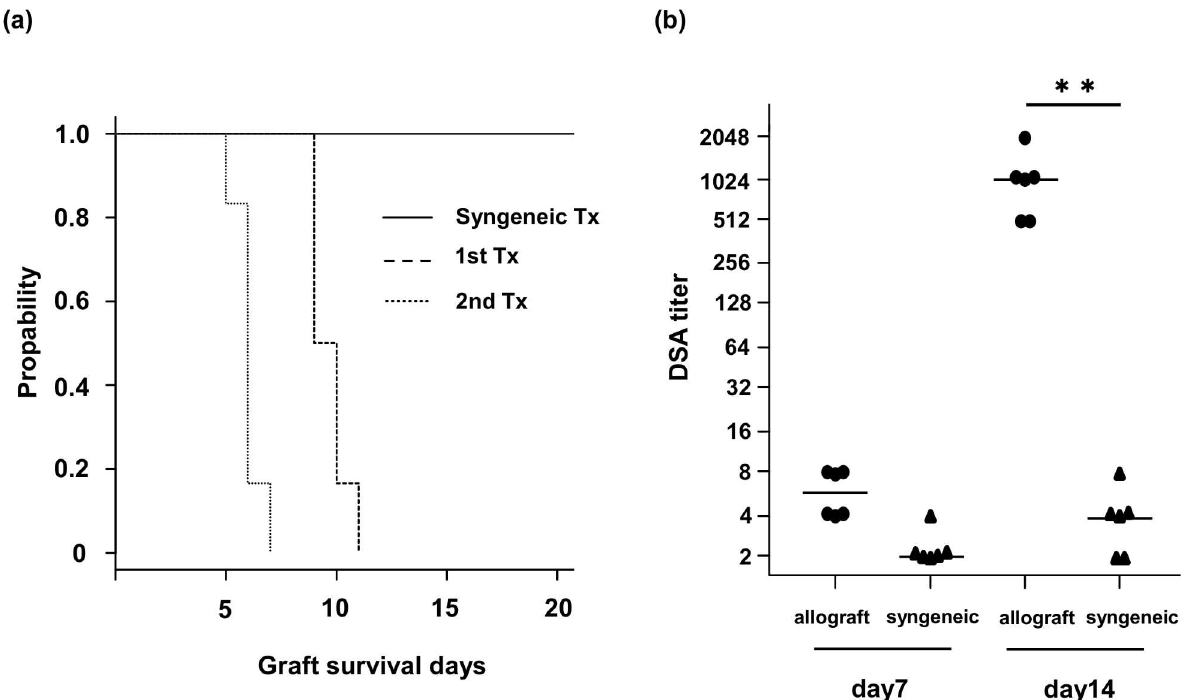
Fig 6. Survivalcurveof transplantedskin grafts(a) and the kinetics of donor-specificantibodyproduction in skin allografts and syngeneicgraftrecipients (b). (a) Kaplan-Meier curveof skin graft survivalfor the first transplantation (1st Tx, dashed line),second transplantation (2nd Tx, dottedline)and syngenenic transplantation (syngeneic Tx, black line).Skin graft rejectionwas determined macroscopically when the graft reacheda necrosislevel of 90%. The mediangraft survival times of six mice per group were 9.5 (range 9–11)days for 1st Tx and 6 (range5–7) days for 2nd Tx. Syngeneic grafts were not rejectedfor more than 21 days. (b) Production of donor-specific antibodies(DSA) in 1st Tx and syngeneicTx recipients.On days 7 and 14 post-transplant, sera fromeach group (n =